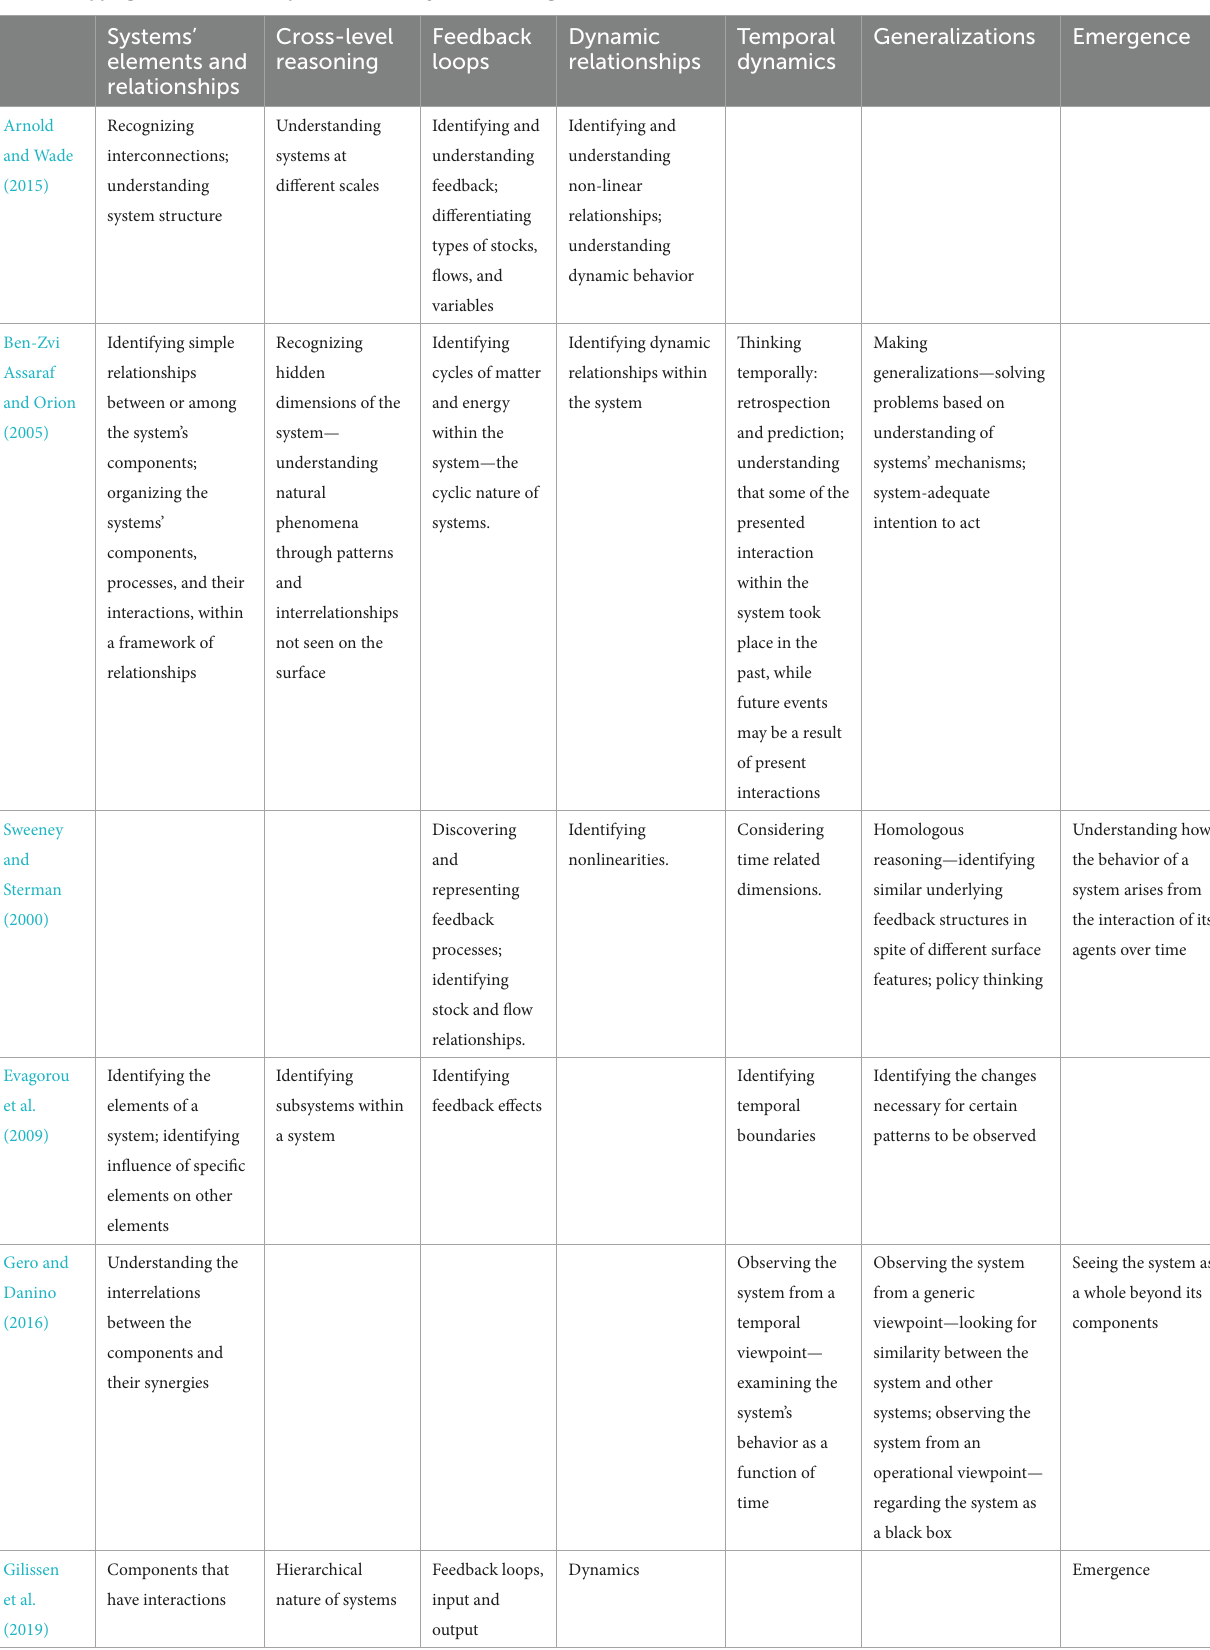
TABLE 1 Mapping of different conceptualizations of systems thinking skills. Systems’ elements